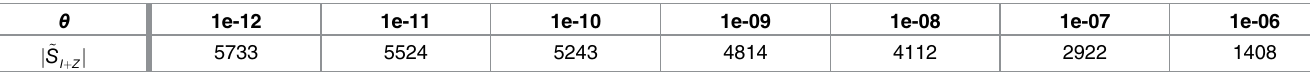
j , the number of clusters + the number of isolated variables, against θ for Dataset3 at δ = 10 − 4 and Table 2. The effectivedegrees of freedom j ~ S I þ Z the optimal parameters (2 λ ℓ , 8 λ T )/ M = (1, 10). 1